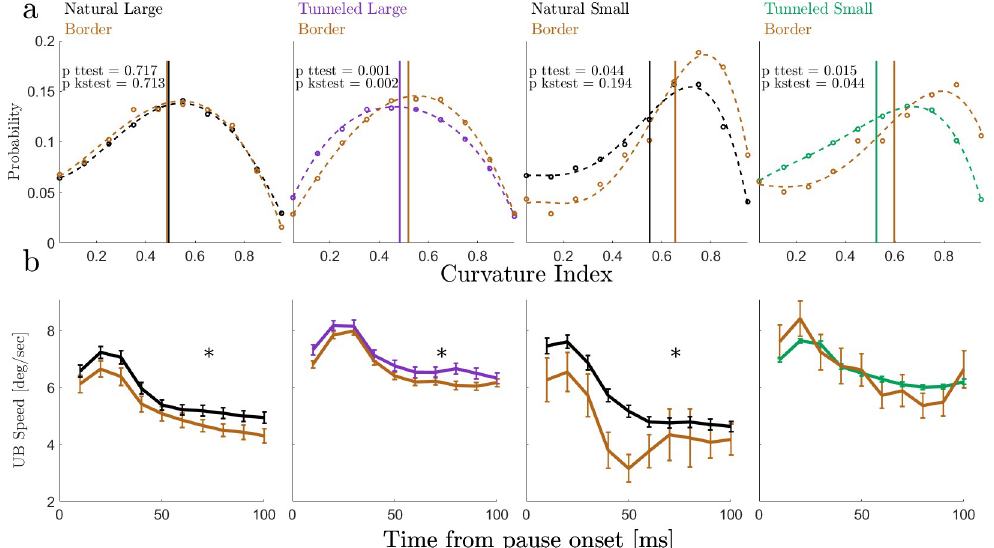
Fig 3. Drifts curvature indices and instantaneous UB-speed. (a) . Normalized distributions of curvature indices of border drift s trajectories (brown) and non-border drifts trajectories, in the four experimental conditions. Natural viewing in black and tunneled viewing in color (large in purple and small in green). The vertical lines depict the mean values of curvature indices per condition. Mean ± SEM of the curvature index and the number of pauses for border and non-border scanning, respectively: 0.48 ± 0.04 vs. 0.49 ± 0.01 for natural-large (n = 192,374 pauses); 0.52 ± 0.01 vs. 0.48 ± 0.01 for tunneled-large (n = 1405,757); 0.65 ± 0.05 vs. 0.55 ± 0.02 for natural-small (n = 23,270); 0.60 ± 0.03 vs. 0.53 ± 0.01 for tunneled-small (n = 66,2723); p-values in each panel are for (i) comparing means using two tailed t-tests and (ii) comparing distributions using two-sample Kolmogorov-Smirnov tests. (b) Mean within-pause instantaneous UB drifts speeds of border drifts and non-border drifts , in the four experimental conditions (colors as in (a)). Mean ± SEM and number of pauses for border and non-border scanning (target speed values, for time > 50ms), respectively: 4.64 ± 0.09 vs. 5.14 ± 0.07 for natural-large (n = 143,310 pauses); 6.19 ± 0.05 vs. 6.56 ± 0.07 for tunneled-large (n = 863,457); 3.9 ± 0.2 vs. 4.81 ± 0.07 for natural-small (n = 19,229); 5.9 ± 0.2 vs. 6.20 ± 0.03 for tunneled-small (n = 48,1851); ( � , p < 0.05, two tailed